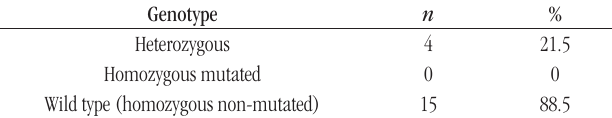
taBLE 2 − Molecular profiling of patients regarding FVL